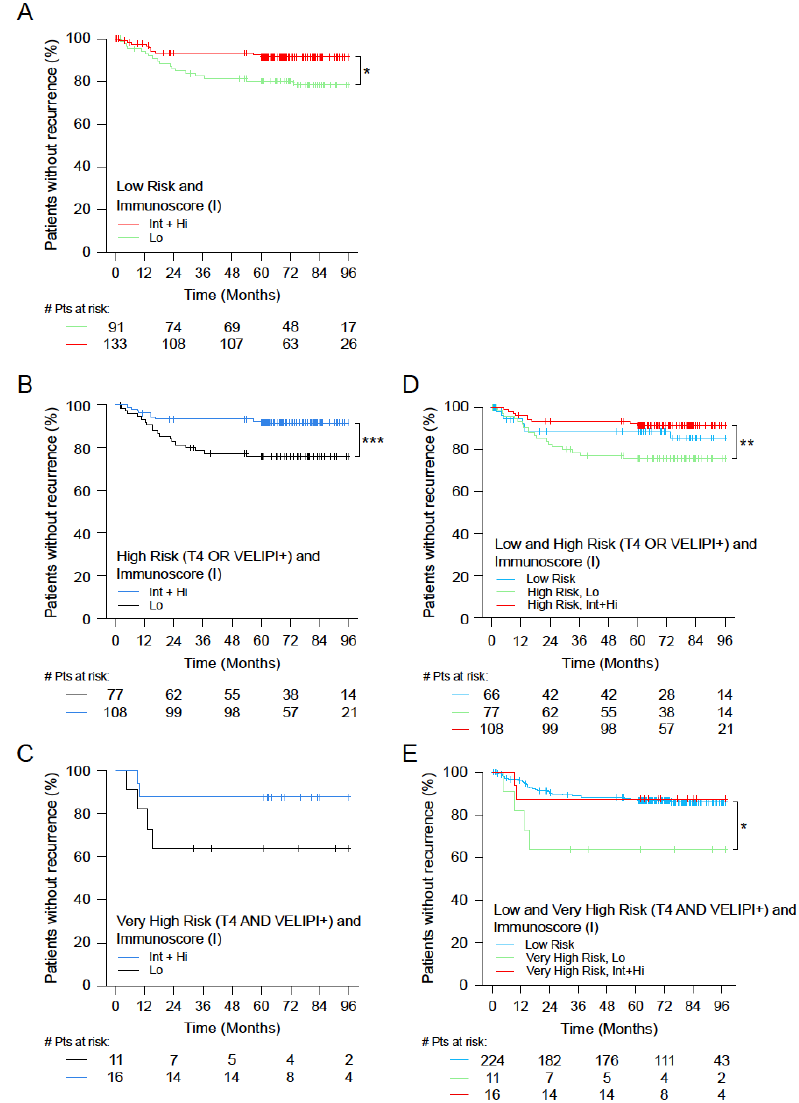
Figure 5. The impact of Immunoscore on the outcome of low- and high-risk colon cancer patients. Kaplan–Meier curves of Low (Lo, 0–25%) and Intermediate+High (Int+Hi, >25–100%) Im- munoscore are shown for TTR ( A – C ). ( A ) Low-risk patients, Immunoscore Lo (green) and Int+Hi (red). ( B ) High-risk patients (T4 and VELIPI+), Immunoscore Lo (black) and Int+Hi (blue). ( C ) Very high-risk patients (T4 or VELIPI+), Immunoscore Lo (black) and Int+Hi (blue). ( D ) Low and high-risk patients (T4 or VELIPI+). ( E ) Low and very high-risk patients (T4 and VELIPI+). Significant log-rank p -values are marked as *** p < 0.005, ** 0.005 ≥ p < 0.01, and * 0.01 ≥ p < 0.05.